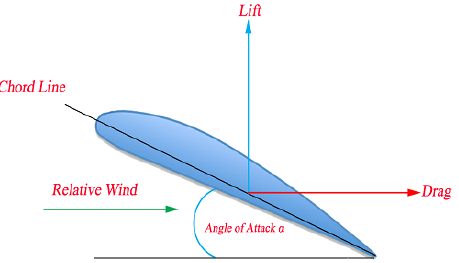
Figure 2. Definition of the angle of attack of the aerodynamic profile.